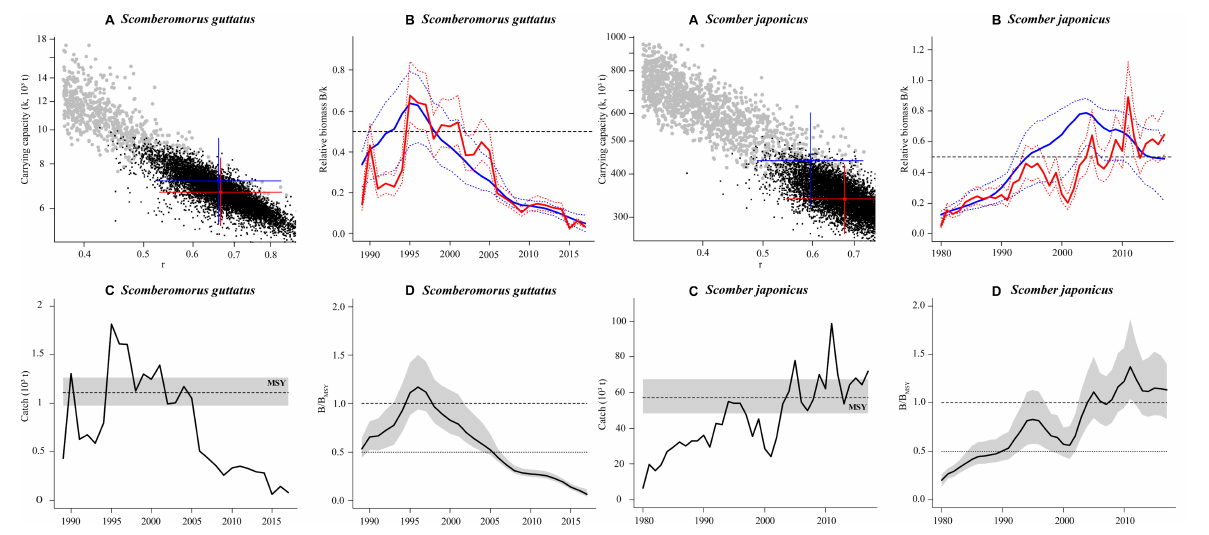
FIGURE 3 | Results of BSM outputs for the collapsed stock Indo-Pacific king mackerel Scomberomorus guttatus (left four panels) and the healthy stock chub mackerel Scomber japonicus (right four panels). Panel (A) shows the viable r - k pairs found by CMSY method (gray dots) and BSM method (black dots), and the blue cross is the most probable r - k pair with its 95% confidence interval (CI) found by CMSY, whereas red cross indicates the most probable r - k pair and its 95% CI found by BSM. Panel (B) shows the biomass trajectories (lines) with the 2.5th and 97.5th percentiles (dotted lines) estimated by CMSY (blue) and BSM (red). Panel (C) shows catch relative to the BSM estimate of MSY, with indication of 95% CI in gray. Panel (D) shows the development of relative total biomass (B/B MS Y), with CI (gray area) indicating